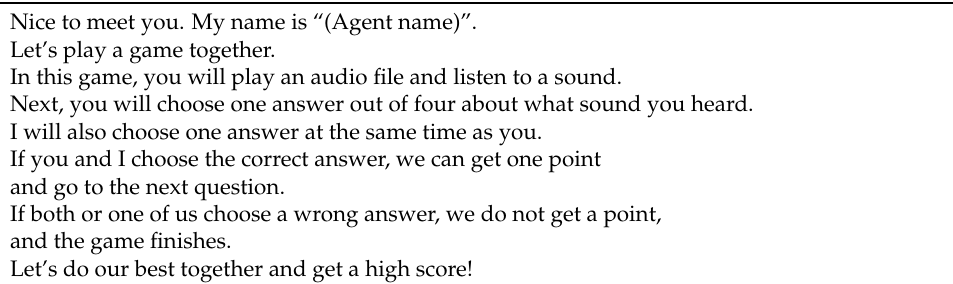
Table 4. Speech text in the introduction